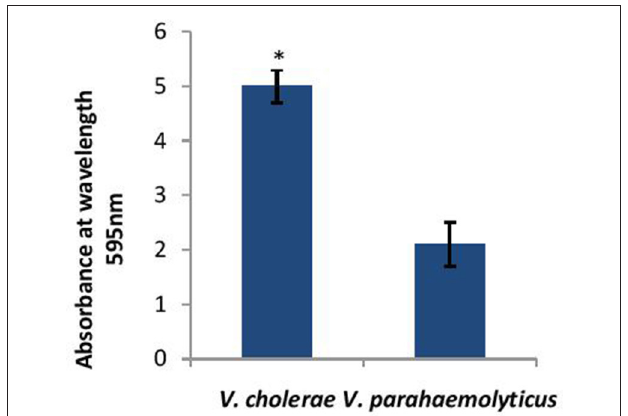
FIGURE 2 | Biofilm forming abilities of V. cholerae and V. parahaemolyticus evaluated by crystal violet assay performed in microtiter plate. Bars represent the mean and error bars represent standard deviation of three independent experiments. *Significance ( p < 0.001) was calculated by using an unpaired Student’s t -test.